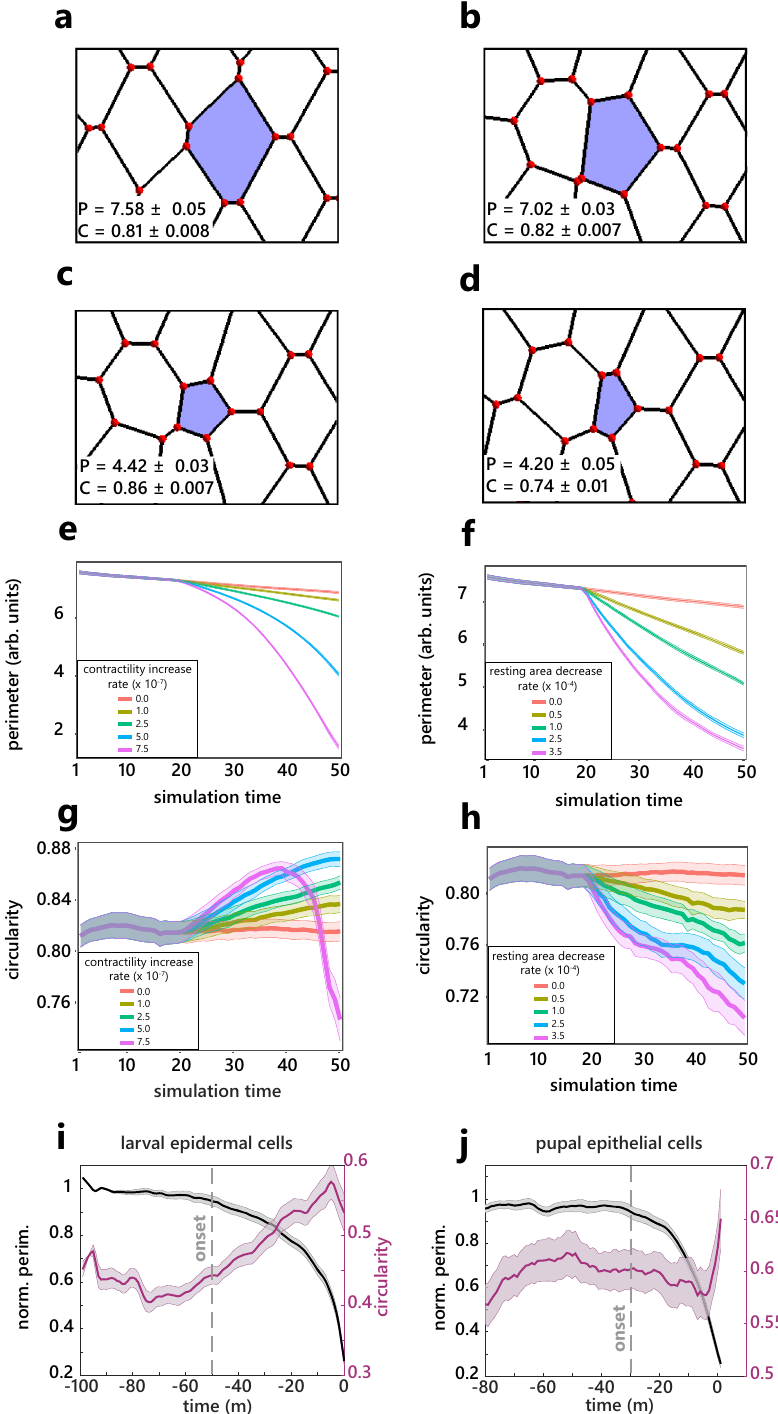
Fig. 2 Cell extrusion in the midline is different from purse-string driven extrusion. a – d Examples of a tracked cell (blue) from a vertex model during the early extrusion phase at different simulation time steps (sts) and under different conditions. P is the average perimeter ± SEM, and C denotes average circularity± SEM for the ten tracked cells of the simulations. a Initial state at sts = 1. b Control simulation (no change of parameter in the blue cell) at sts = 40. c Extrusion driven by increased cell contractility e Γ α (contractility increase rate c = 7.5.10 − 7 ), at sts = 40. d Extrusion through the decreased resting area A α ð 0 Þ (resting area decrease rate r = 3.5.10 − 4 ) at sts = 40. e , f Averaged cell perimeter ± SEM for ten tracked cells as a function of contractility increase rate ( e ) and of resting area decrease rate ( f ). Variation of contractility and resting area was initiated at sts = 20. g , h Average cell circularity ±SEM for ten tracked cells as a function of contractility increase rate ( g ) and of resting area decrease rate ( h ). Variation of contractility and resting area was initiated at sts = 20. i , j Averaged cell circularity (magenta) and averaged and normalised cell apical perimeter (black) during cell extrusion in larval epidermal cells, n = 37 cells, N = 2 pupae. i and in the pupal notum epithelial cells, n = 22 cells, N = 2 pupae ( j ). Light colour areas are SEM. Grey dotted lines show the onset of extrusion. Source data are provided in the source data fi le.